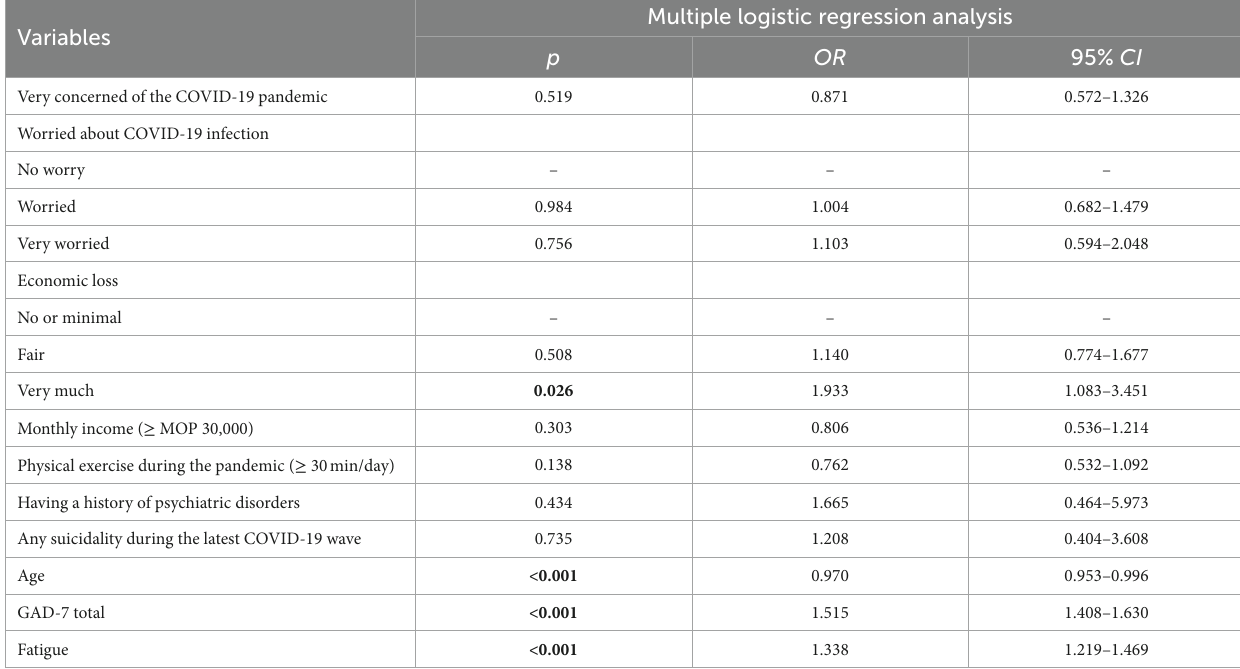
TABLE 2 Independent correlates of depressive symptoms among Macau residents during the 618 COVID-19 wave ( N = 1,008).